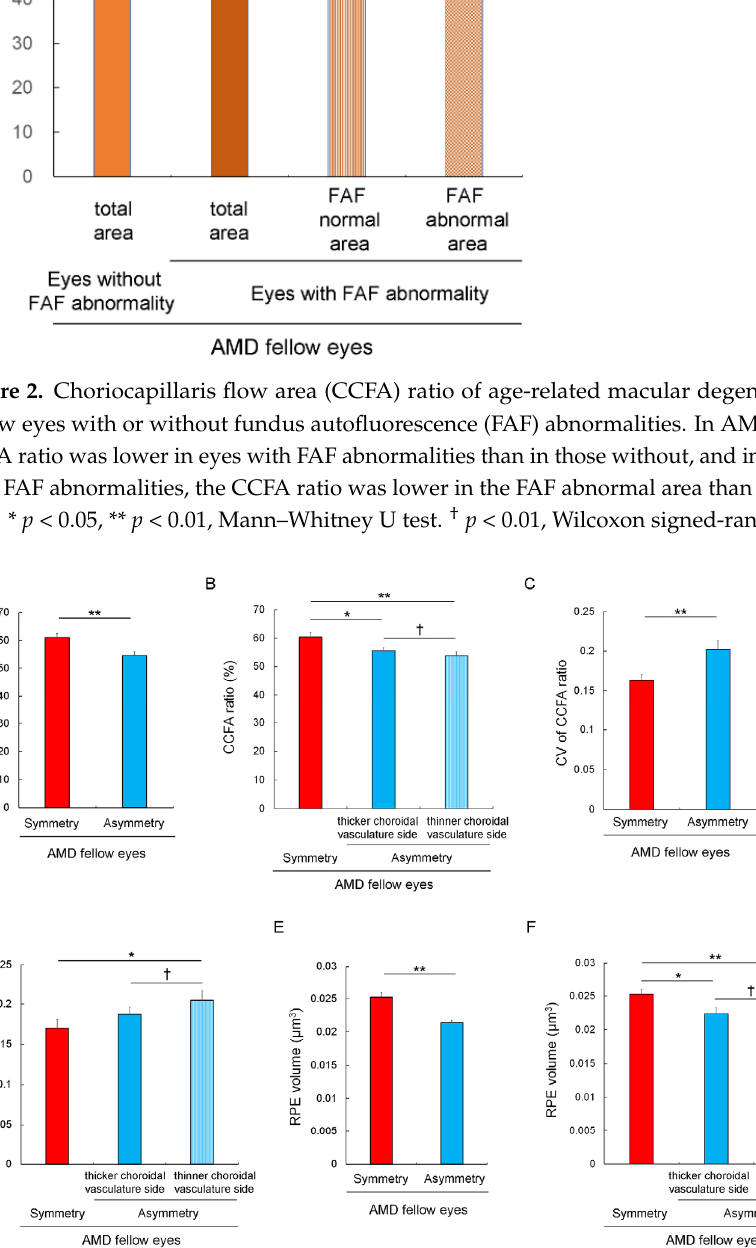
Figure 3. Choriocapillaris flow area (CCFA) ratio, coefficient of variation (CV) of the CCFA ratio, and the retinal pigment epithelium (RPE) volume of AMD fellow eyes with symmetric or asymmet- ric choroidal vasculature. The total area of the CCFA ratio of AMD fellow eyes with asymmetric choroidal vasculature was smaller than that of those without ( A ), and in AMD fellow eyes with asymmetric choroidal vasculature, the CCFA ratio was lower in the thinner, rather than thicker, choroidal vasculature side ( B ). Both sides exhibited a lower CCFA ratio than the average value of the upper and lower sides of eyes with symmetric choroidal vasculature ( B ). The total area of the CV of the CCFA ratio in AMD fellow eyes with asymmetric choroidal vasculature was greater than that in those without ( C ), and in the AMD fellow eyes with asymmetric choroidal vasculature, the CV of the CCFA ratio was greater in the thinner, rather than, the thicker choroidal vasculature side ( D ). The thinner side exhibited a greater CV of the CCFA ratio than the average value of the upper